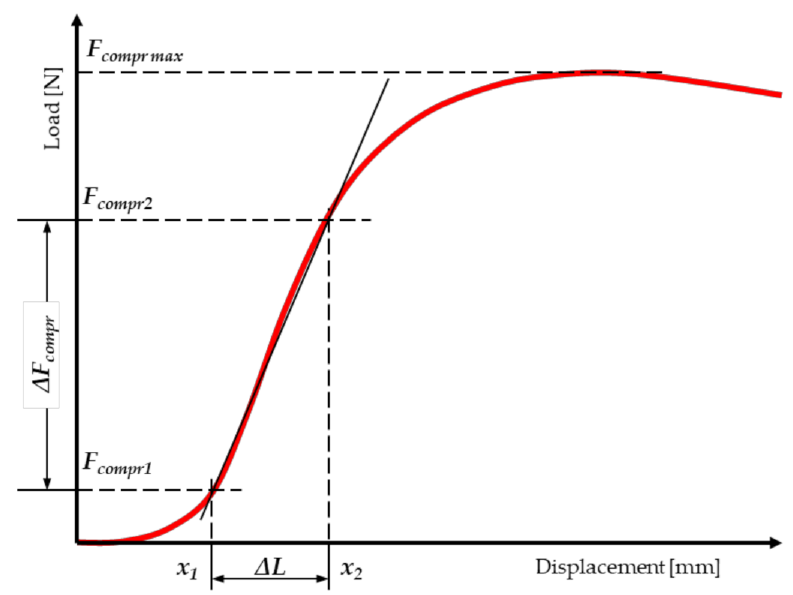
Figure 4. Dependence of force on displacement for the static compression test along the fibers of miscanthus